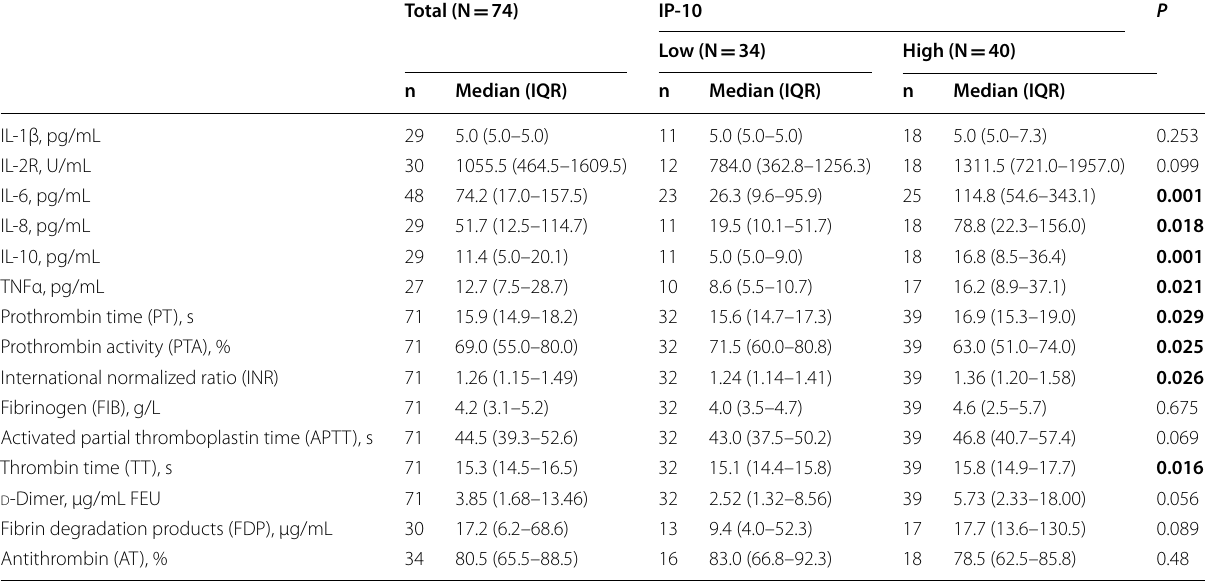
Bold indicates the statistically significant values ( P < 0.05)